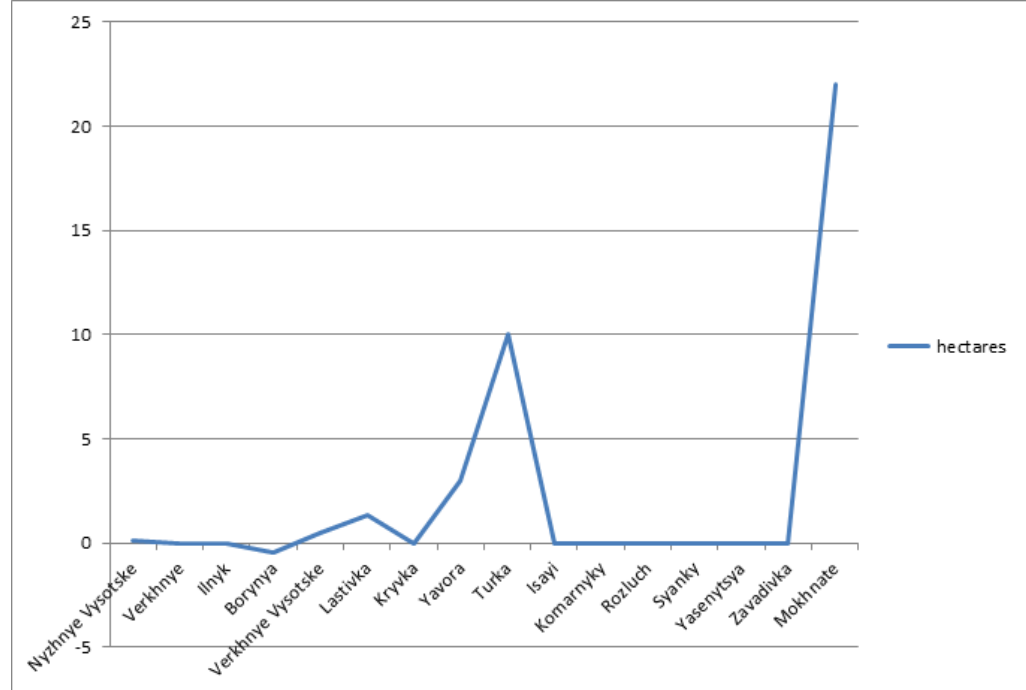
Fig. 2. Dynamics of the areas occupied by Heracleum sosnovskyi in Turka district of the Lviv region (Conducting measures for the protection…, 2016)